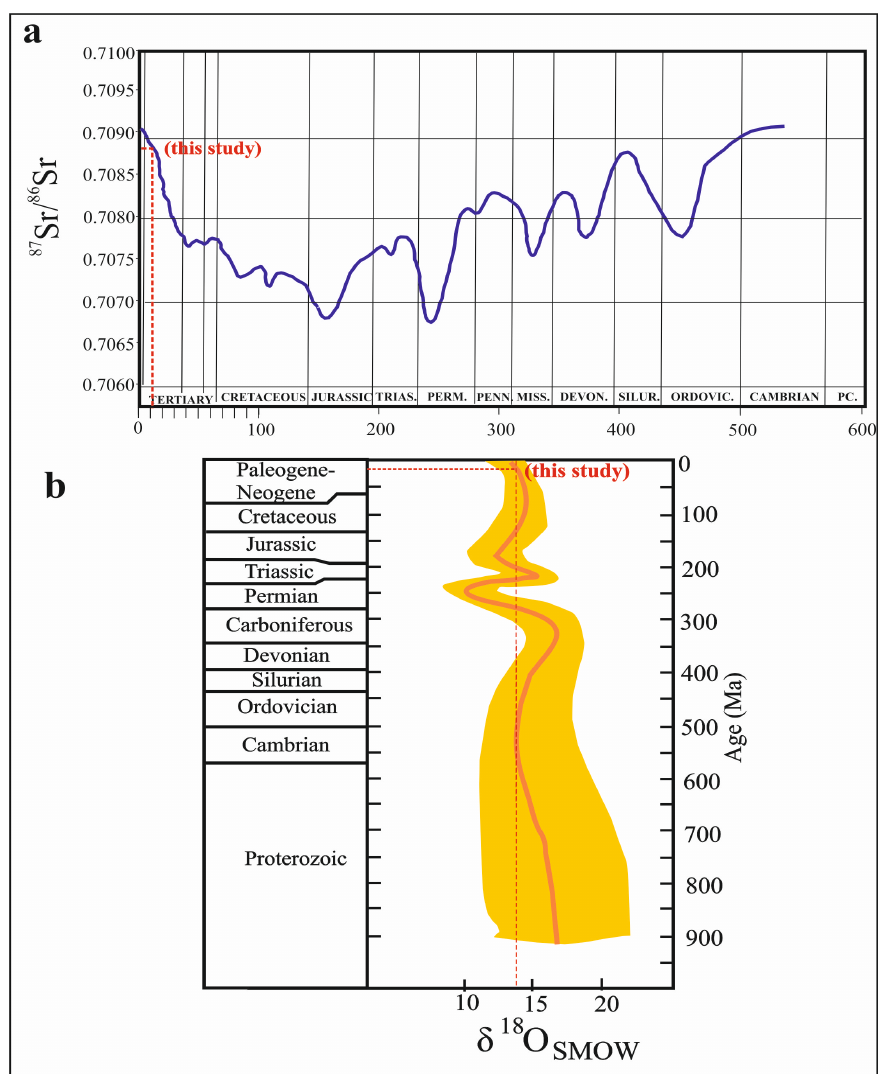
Figure 10. ( a ) 87/86 Sr isotopic curve of seawater strontium during the latest 1000 Ma interval [78]; ( b ) marine sulfate sulfur and oxygen isotope age curves (modi fi ed from [85]).